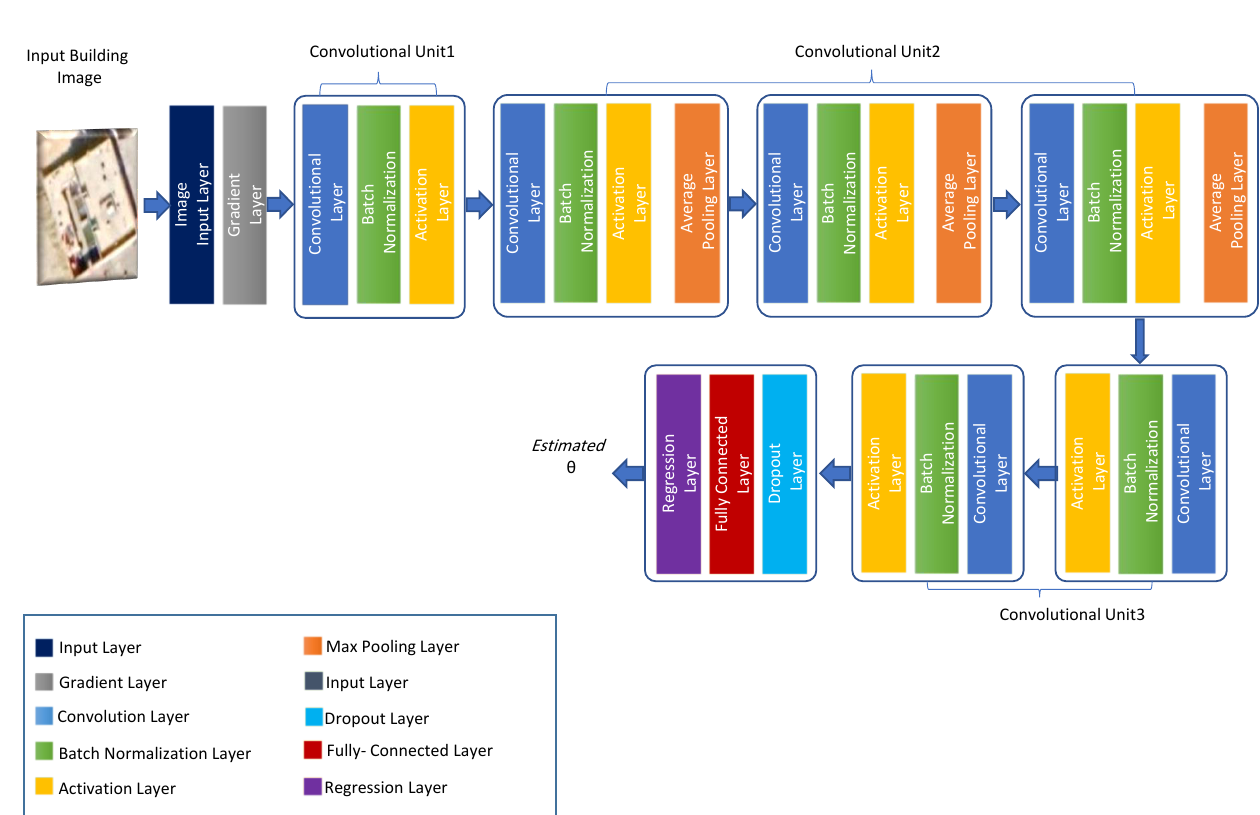
Figure 4. The second proposed approach based on DCRN for building angle orientation estimation.